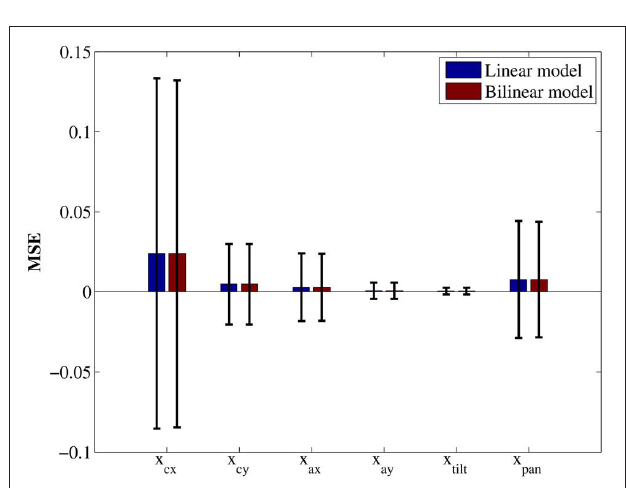
FIGURE 8 | Mean squared error of each state variable. Each error bar represents the standard